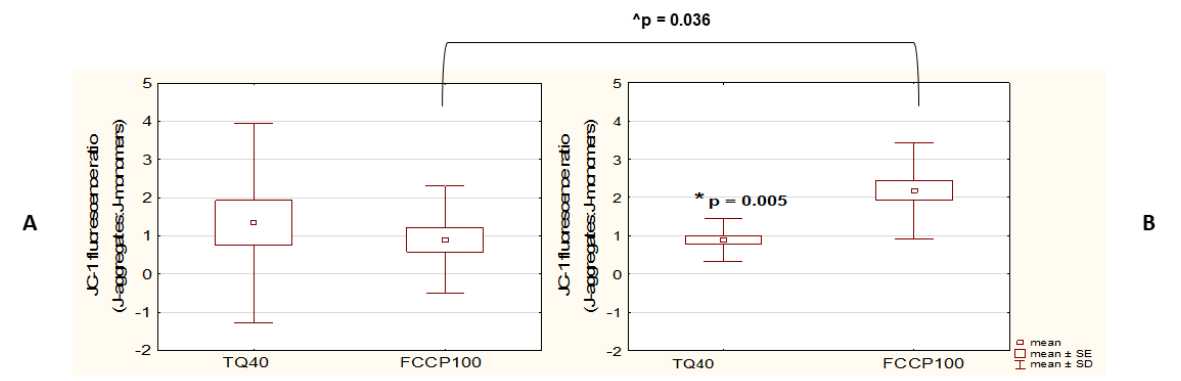
Figure 6. WM9 cell line shows higher sensitivity to 40 μ M TQ than to FCCP. Spectrofluorometric assessment (JC-1) of the mitochondrial membrane potential (  m ) in A375 ( A ) and WM9 ( B ) cells than the A375 cells. treated with 40 μ M TQ for 48 h, or with 100 μ M FCCP, for 4 h. * denotes a significant decrease in  m compared to FCCP control; ^ denotes significant differences between the two analyzed cell lines; data are presented as mean ± SD; p < 0.05 was considered to be statistically significant (Mann – Whitney U test).